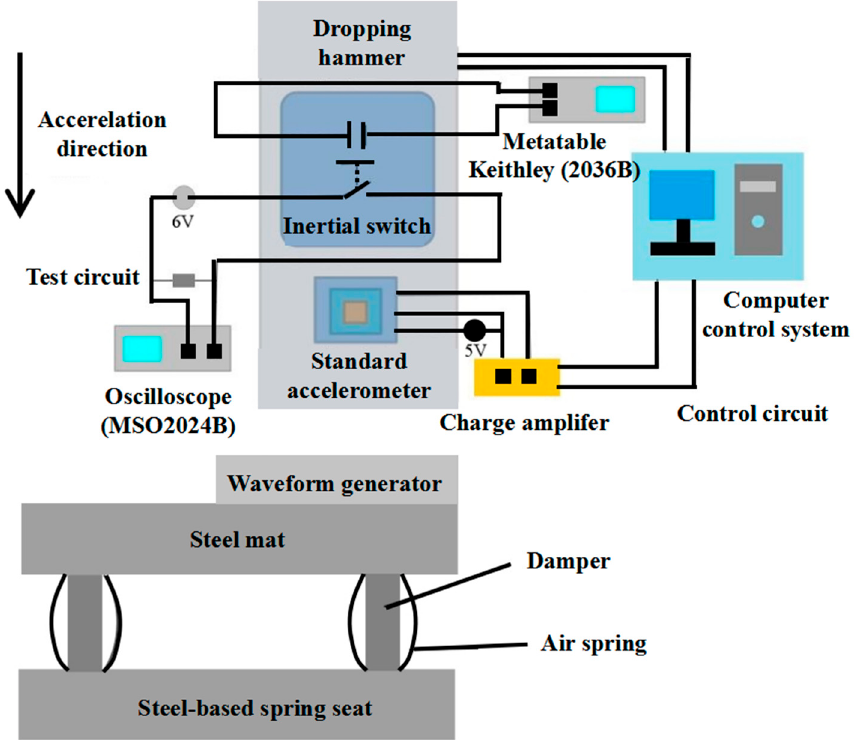
Figure 13. Dropping system of multi ‐ threshold acceleration.